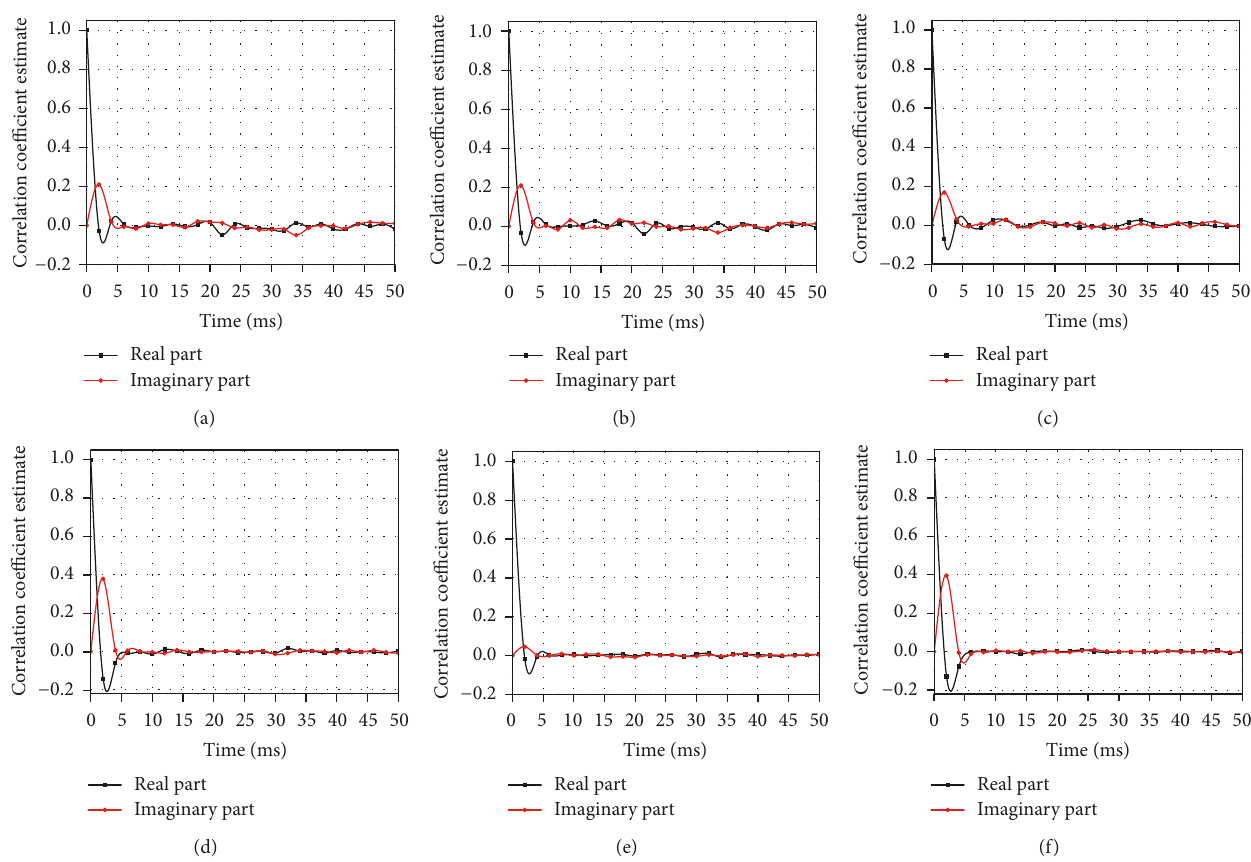
Figure 8: The temporal correlations of the speckle for DS2: ((a)–(c)) sum channel and elevation and azimuth difference channels for the 200th range cell. ((d)–(f)) Sum channel and elevation and azimuth difference channels for the 380th range cell.